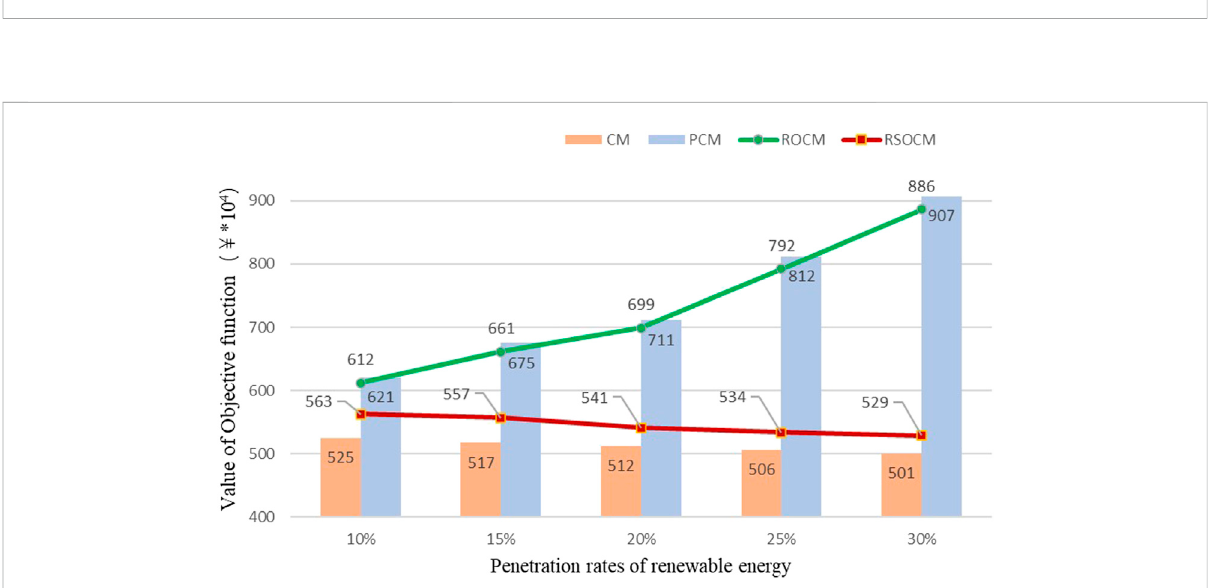
FIGURE 5 Comparison of objective functions of different models under different renewable energy penetration